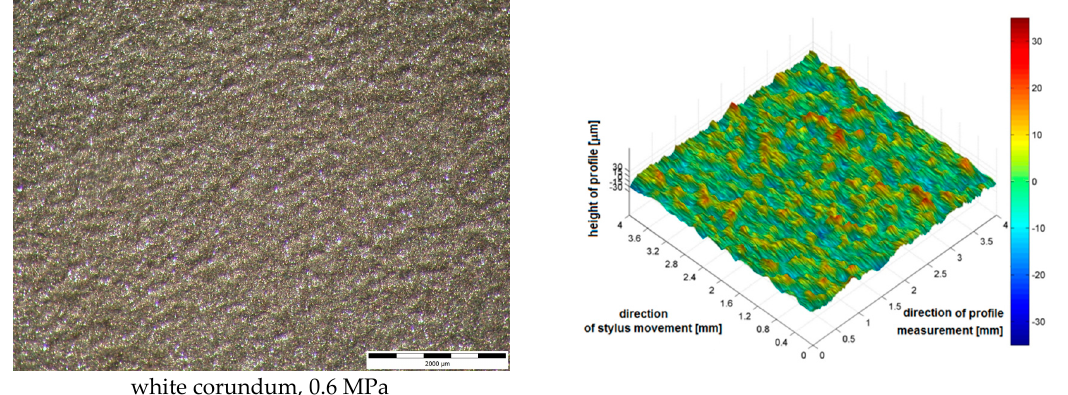
Figure 13. 3D maps and macro views on evaluated surfaces.